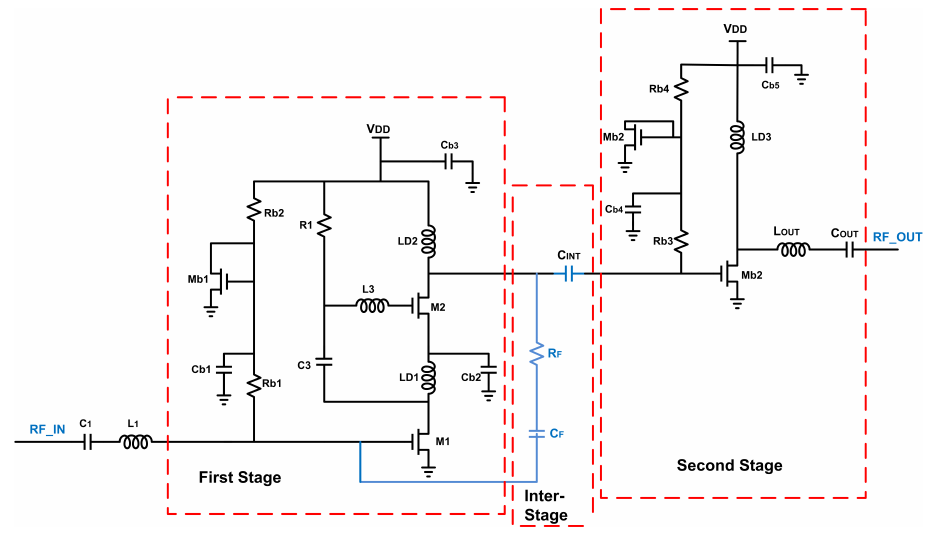
Figure 2. Schematic of proposed UWB power amplifier.